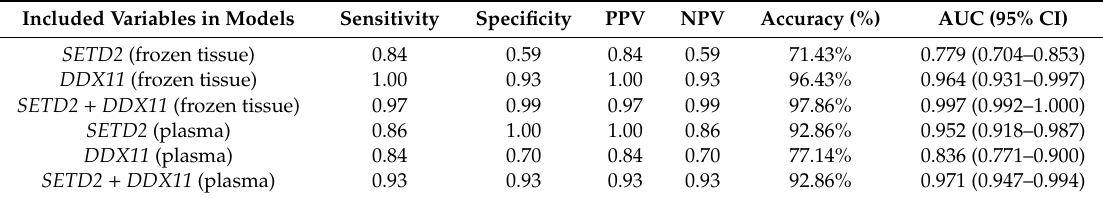
Table 3. Performance comparison of logistic regression models for prediction of high-grade clear cell renal cell carcinoma.